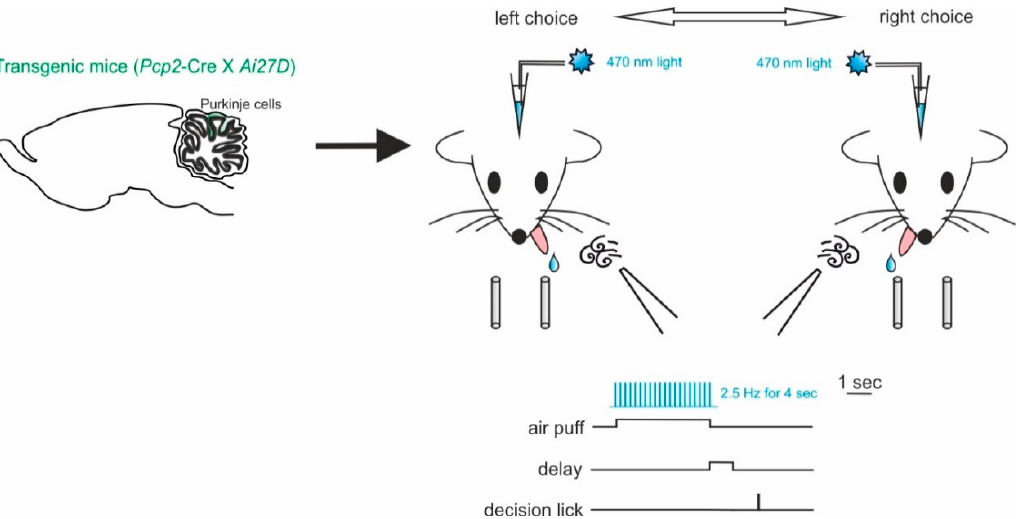
Figure 4. Impaired decision-making by disruption of cerebellar activity during sensory evidence accumulation. Left , mice of genotypes Pcp2 -Cre for PC specificity and Ai27D for ChR2 were used. ChR2-expressing PCs were stimulated using light delivered through optical fibers implanted bilaterally over crus I of the cerebellum. Right , schematic of the evidence-accumulation decision-making task. In each trial, two streams of randomly timed air puffs were delivered to the left and right whiskers. After an 800-ms delay, mice licked one of two lick ports indicating the side with more cumulative puffs to receive a water reward.